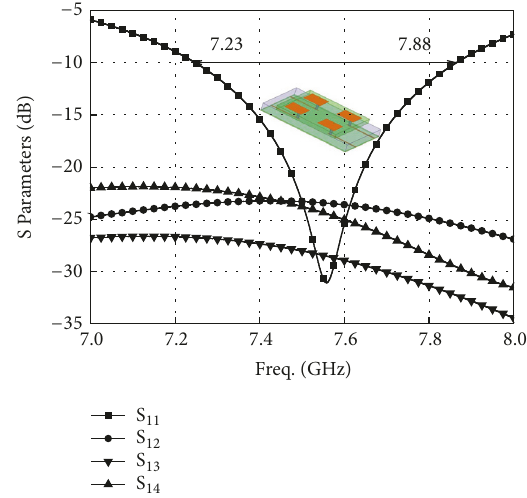
Figure 5: Return loss and inserting loss for the OAM generator (a=18.3mm, 0.46 𝜆 0